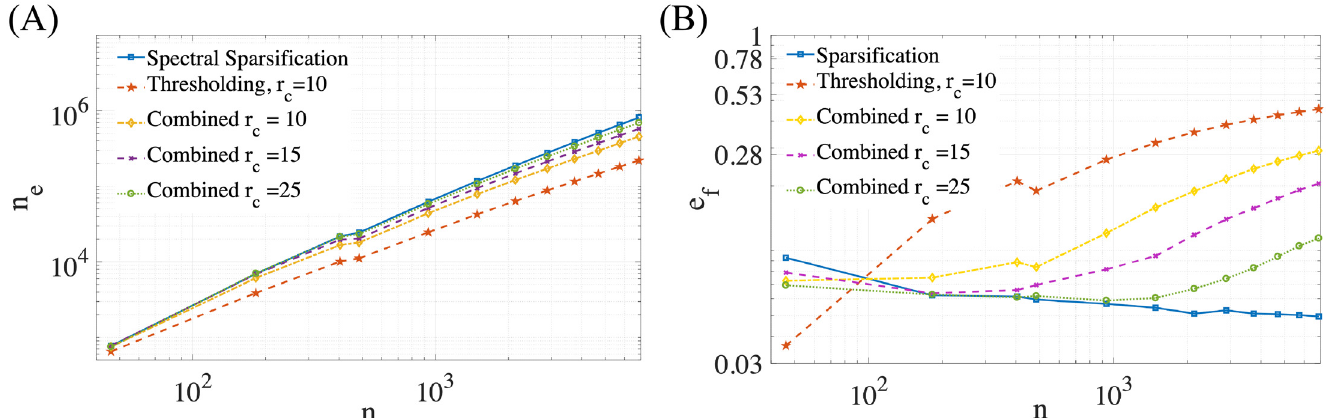
Fig 3. (A) The number of edges as a function of atoms for sparsification, thresholding, and the combined algorithm for multiple cut-off radii (thresholding was done at r c = 10 σ ). (B) Kinematic estimation of local (force) error as a function of number of atoms in the system.